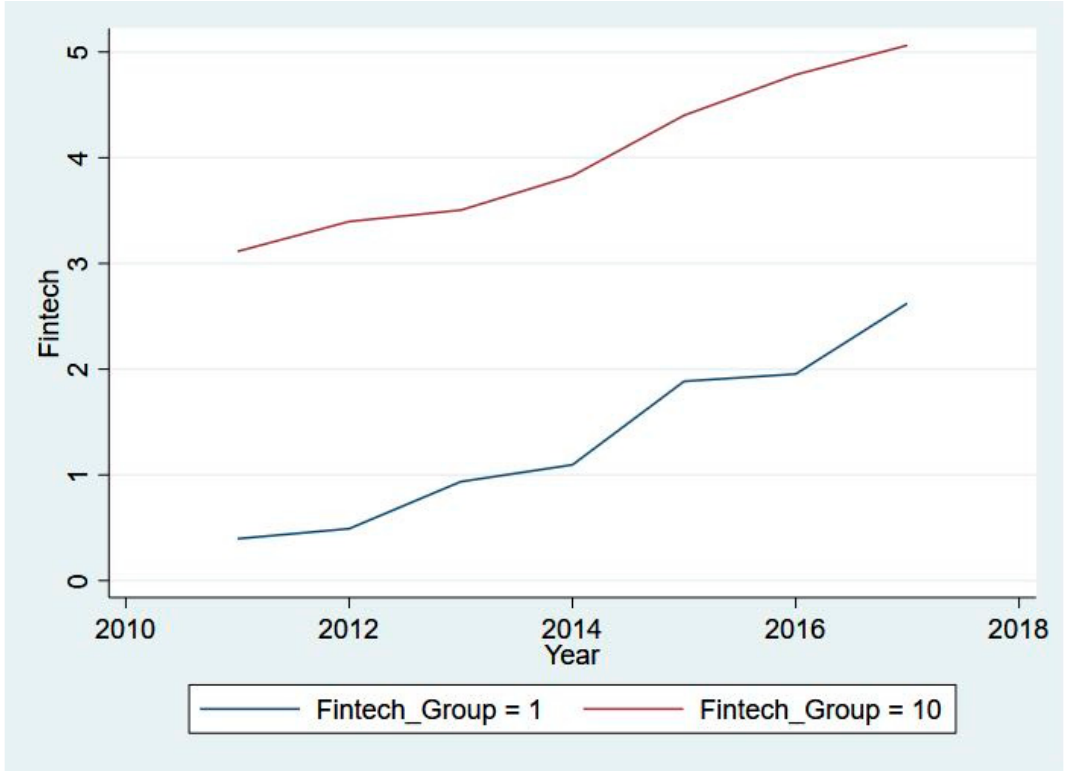
Figure 1. Fintech development for 1st and 10th groups, 2011–2017.